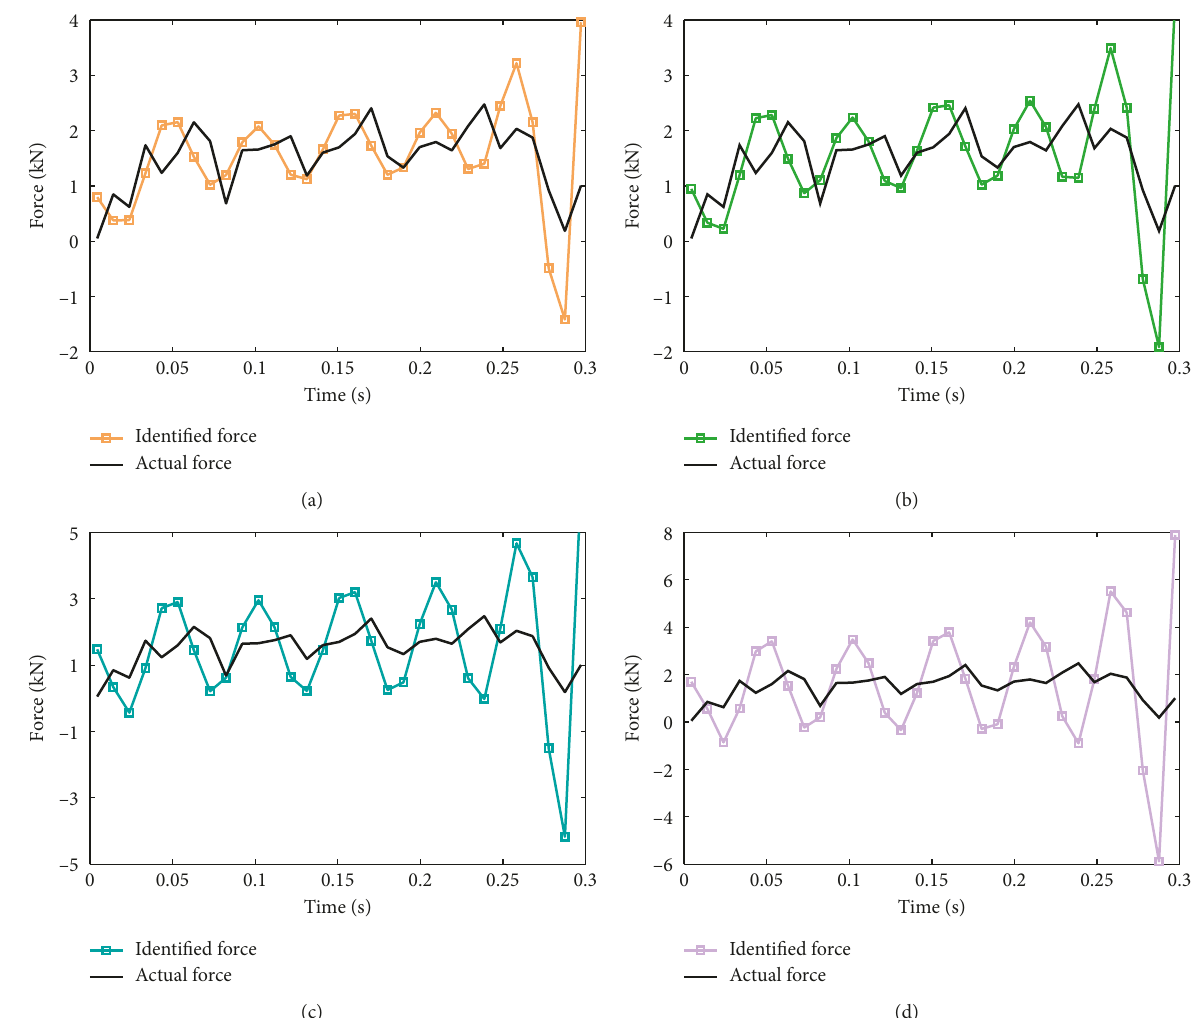
Figure 8: The identified results under different parameter p